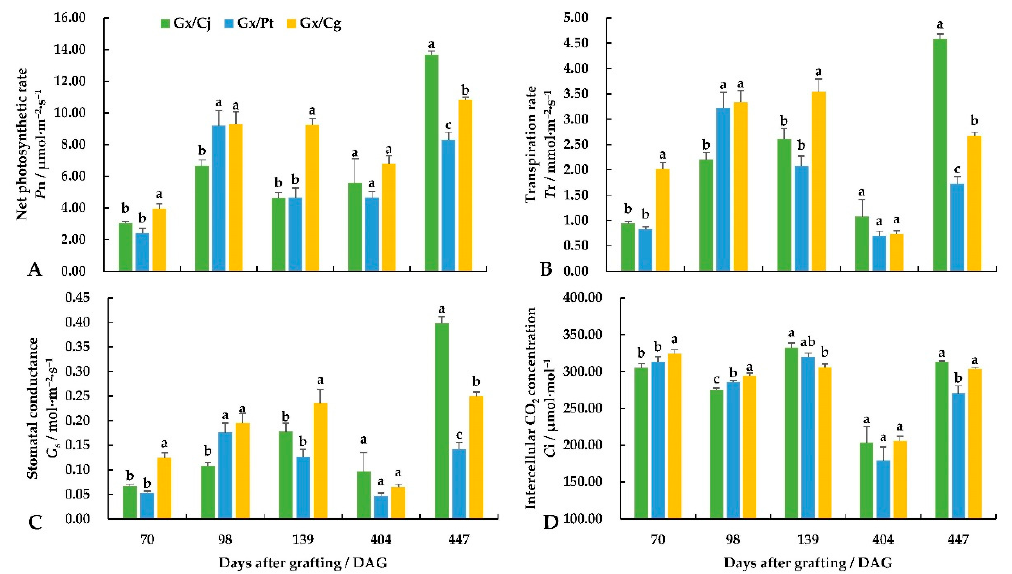
Figure 3. The changes in the net photosynthetic rate ( P n ) (A), transpiration rate ( T r ) (B), stomatal conductance ( G s ) (C) and intercellular CO 2 concentration ( C i ) (D) in the leaves for different stages of ‘Guanxi Miyou’ grafted onto three citrus rootstocks. Different lowercase letters indicate a significant difference at the 0.05 level at the same sampling stage.